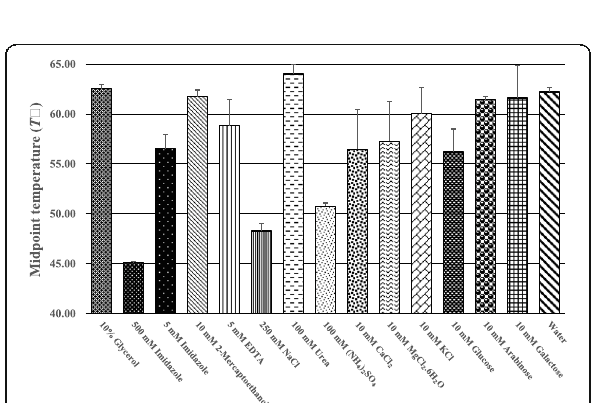
Fig. 2 Midpoint temperatures of the protein-unfolding transition ( T m ) for CelGH5 in the presence of the additives. The control experiment is water, represented as a